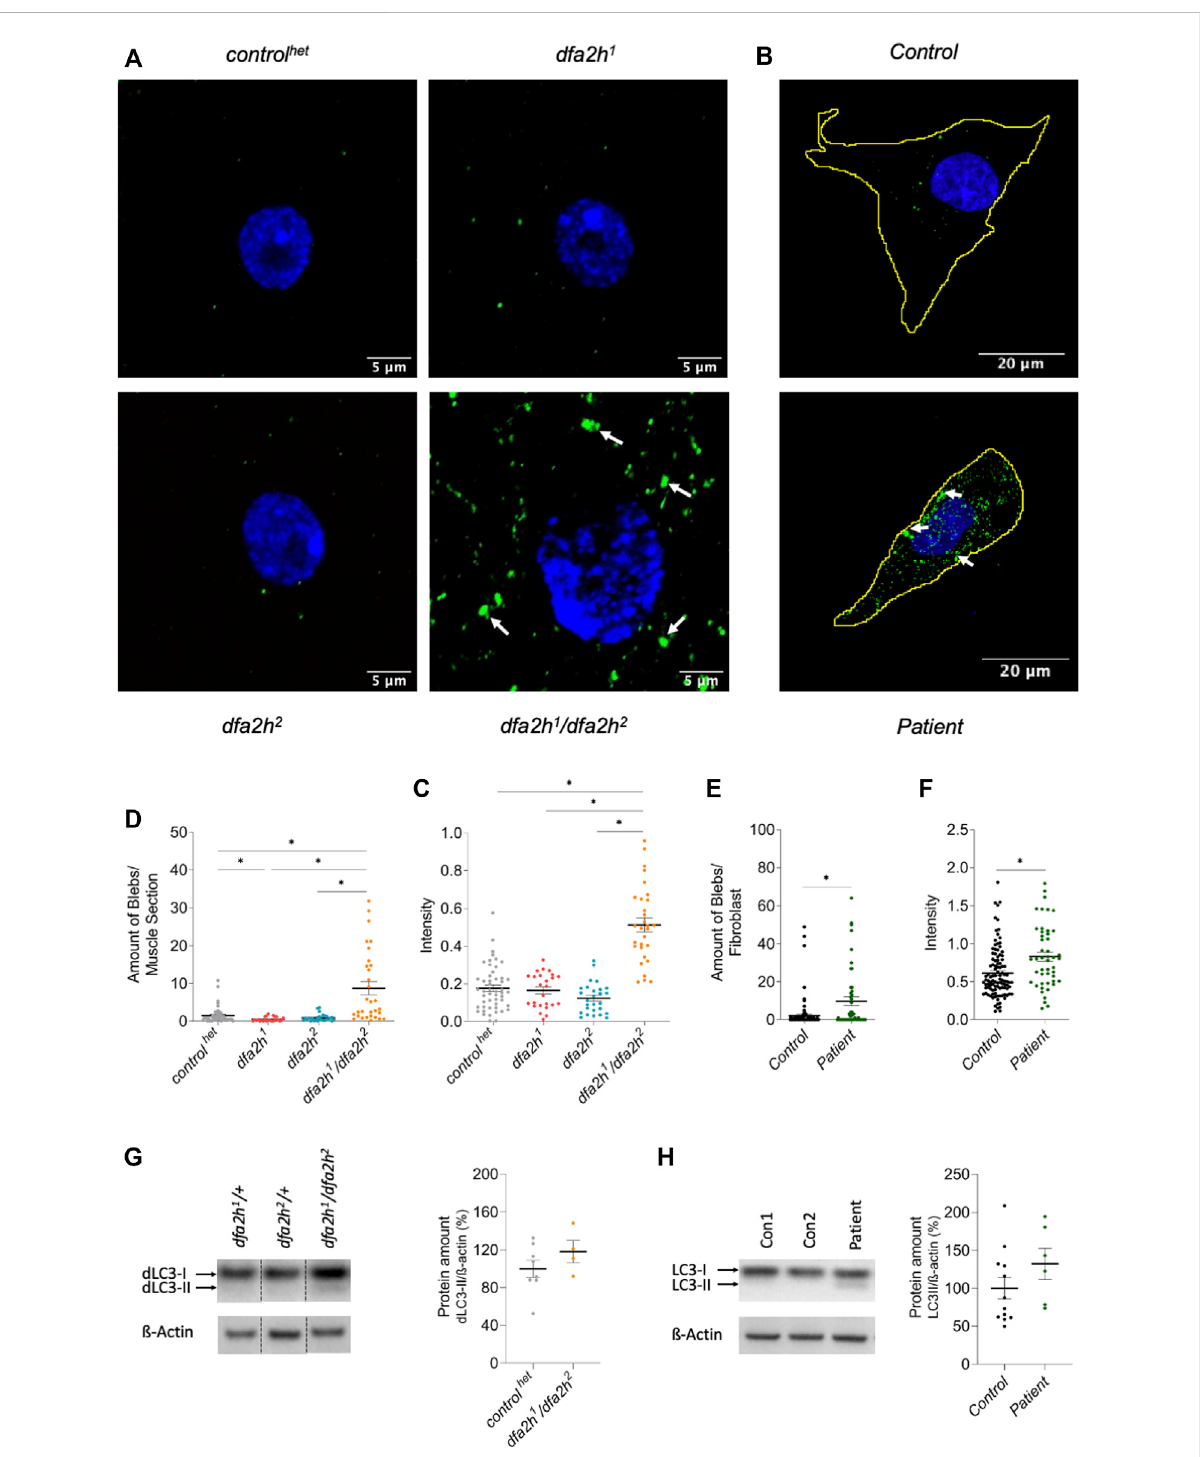
FIGURE 2 Lack of FA2H leads to altered autophagy. (A – C) Immunolabeling of larval muscle sections using autophagy marker dLC3. (A) Confocal microscopy images show autophagy alteration in compound heterozygous dfa2h mutant. The green labeling shows dLC3 labeling visualizing autophagy,andthebluesignalDAPIlabelingtovisualizethenucleus.ThearrowsindicatedLC3accumulations. (B) dfa2h 1 /dfa2h 2 mutant fl iespresent with a higher number of blebs bigger than 0.1 µm 2 compared to control het and homozygous dfa2h mutants. (C) Compound heterozygous mutant demonstrates stronger mean intensity of fl uorescent signal compared to control het and homozygous dfa2h mutants. The dots represent single data points, and the lines show mean ± SEM ( n = 25 – 50). (D – F) Immunolabeling of patient-derived fi broblasts using the autophagy marker